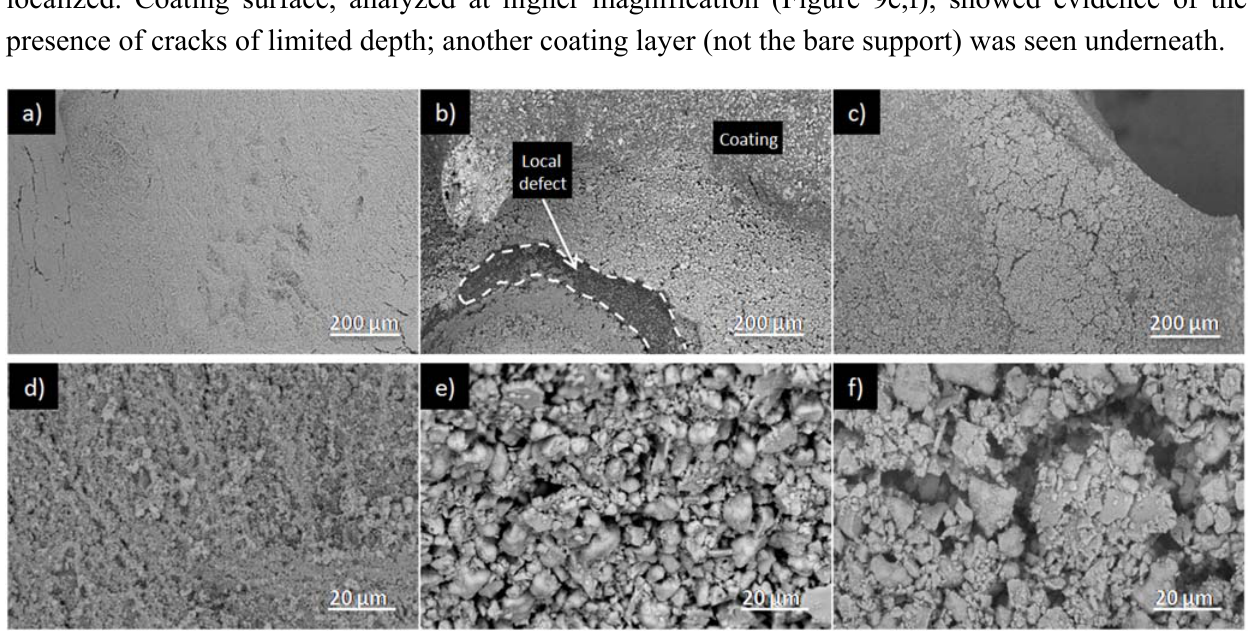
Figure 9. Back scattering SEM analysis of ZrLS, ( a , d ), NiZrLS ( b , e ) and CoZrLS ( c , f ) coated samples after three dippings at different magnifications (100X and